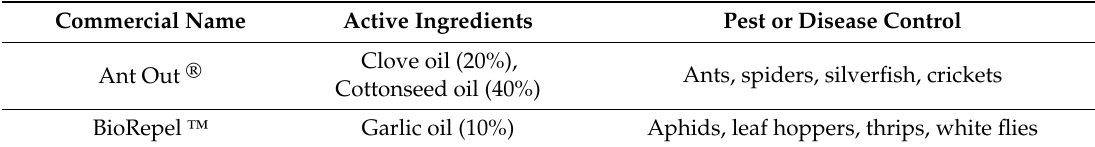
Table 3. Some organic commercial pesticides based on essential